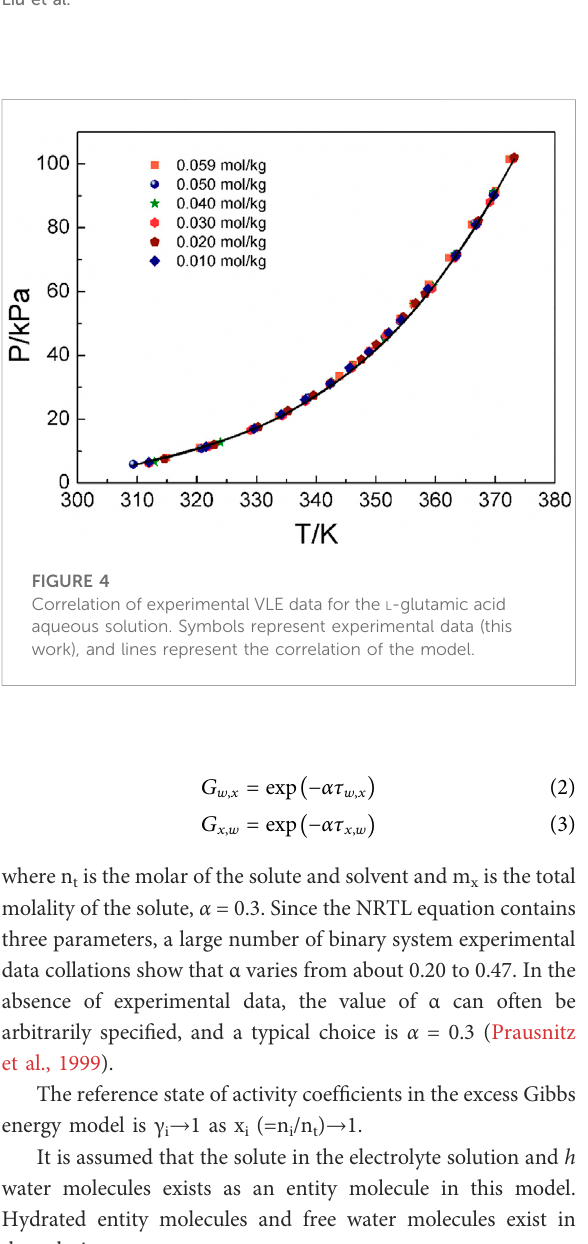
FIGURE 6 Correlation of experimental VLE data for the DL -proline aqueous solution. Symbols represent experimental data (this work), and lines represent the correlation of the